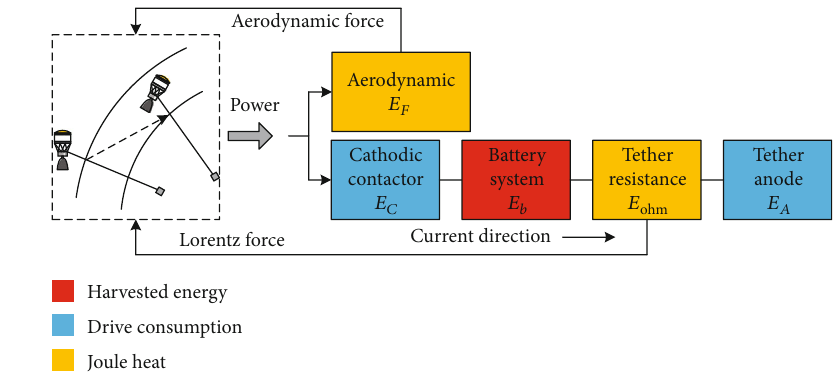
Figure 6: Energy distribution in the tether system.